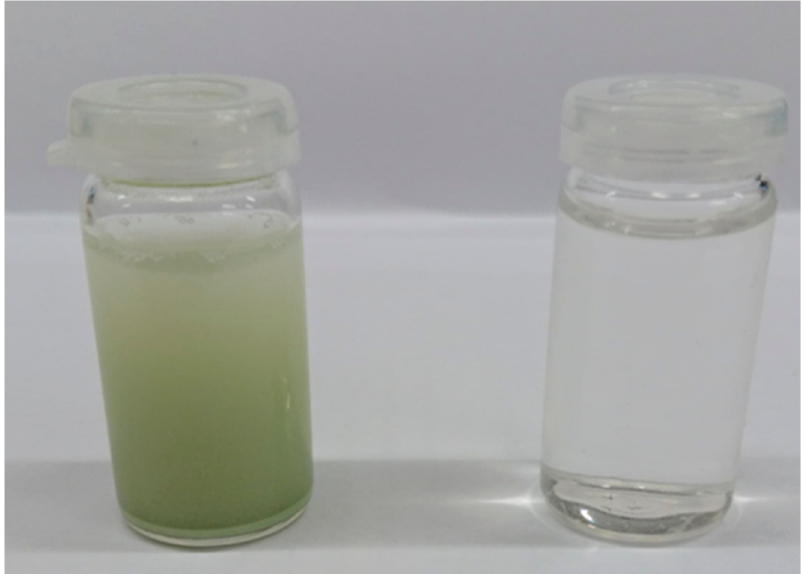
Figure 1. The photographs of WO 3 suspensions before (left) and after (right) the exfoliation process.